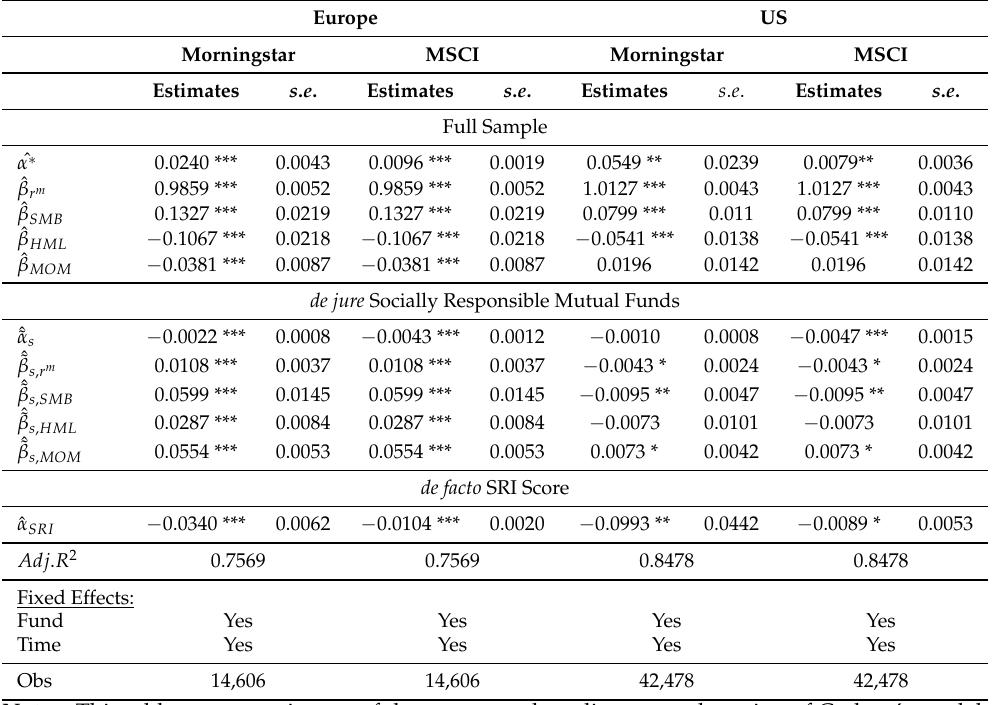
Table 11. Estimation of the augmented nonlinear panel version of Carhart’s model (2013–2018). Europe